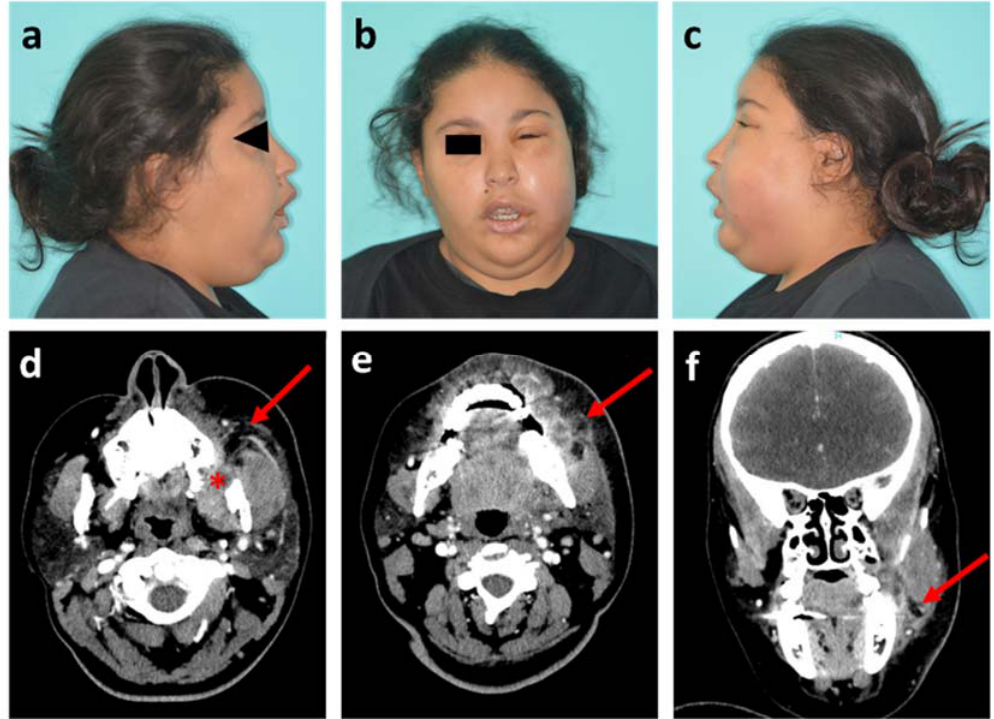
Figure 1. Photographs and head and neck CT scan of patient 1. ( a – c ) Visible images of healthy right profile, front view and affected left profile, respectively; ( d , e ) Axial plane of CT scan in soft tissue window, at maxillary level with the socket of the tooth #28 (red star) and at mandibular level, respectively; ( f ) Sagittal plane of CT scan. Red arrows show the infectious collection.